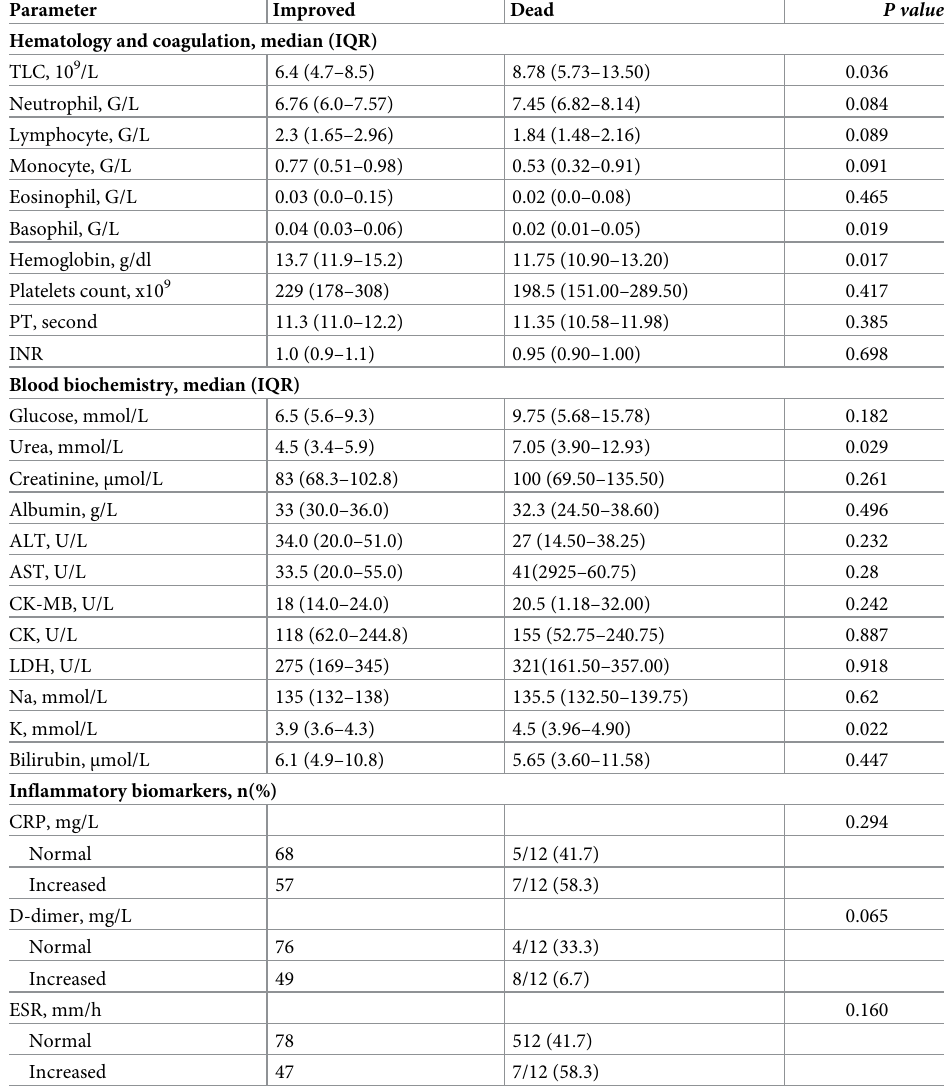
Table 4. Laboratory investigation associated with COVID-19